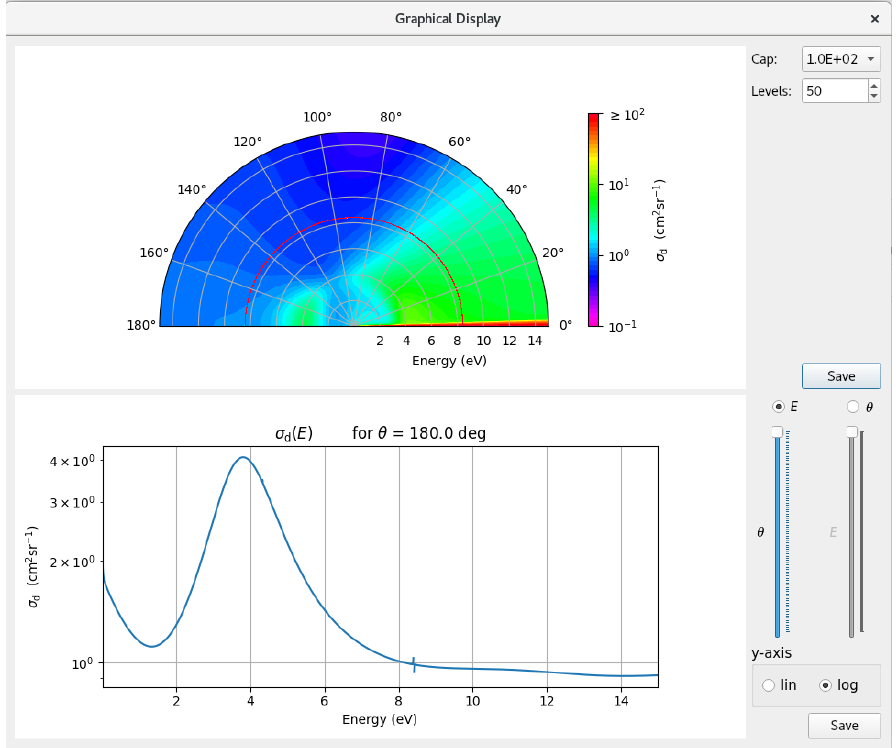
Figure 7. Differential cross sections for CO as displayed by the QEC